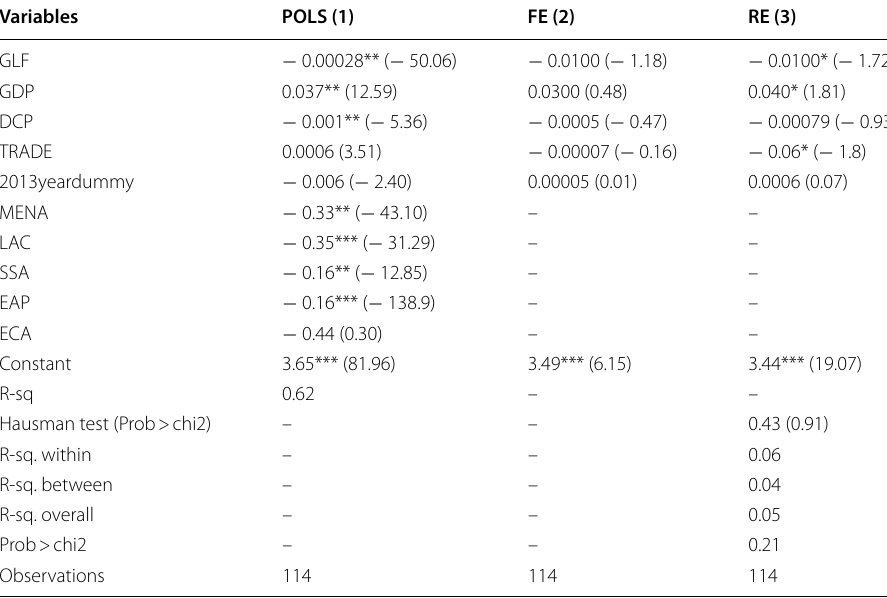
Table 3 Results based on panel data